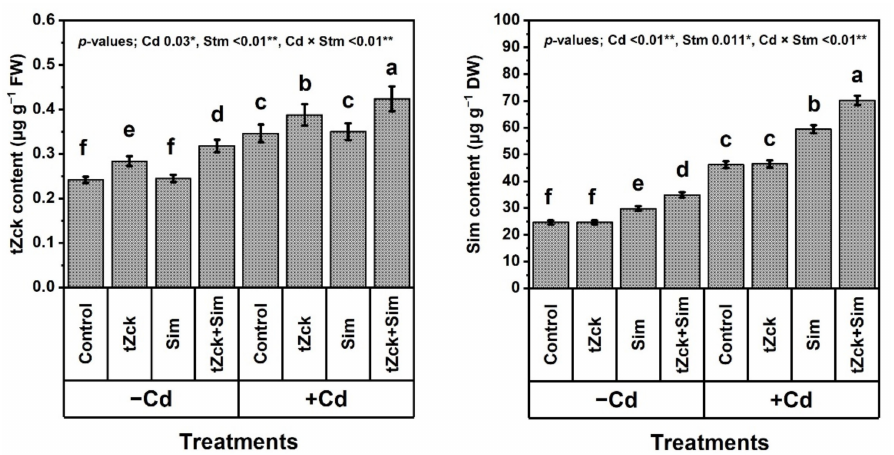
Figure 7. Silymarin (Sim) and trans -zeatin-type cytokinin ( t Zck) contents of wheat (cv. Sakha 93) treated with two stimulators (Stm) i.e., Sim (0.5 mM) and tZck (0.05 mM) under cadmium (Cd; 0.6 mM) stress. The same letters with mean values ± SE in each plot indicate non-significant differences based on LSD test ( p ≤ 0.05). * and ** refer to significant difference at p ≤ 0.05 and p ≤ 0.01, respectively. t Zck; trans -zeatin-type cytokinin, Sim; silymarin, − Cd; without cadmium treatment, +Cd; cadmium treatment and Stm;